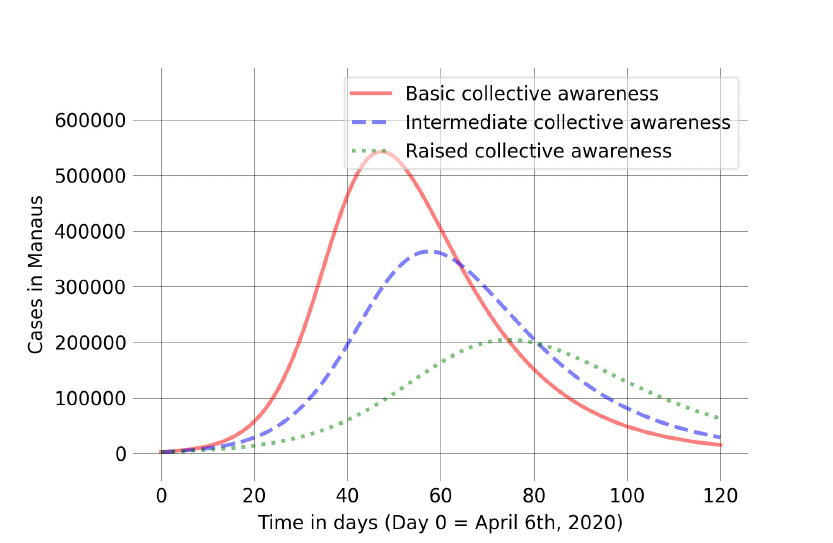
Figure 3. Controlling the isolation rate of infectious individuals – 120 days